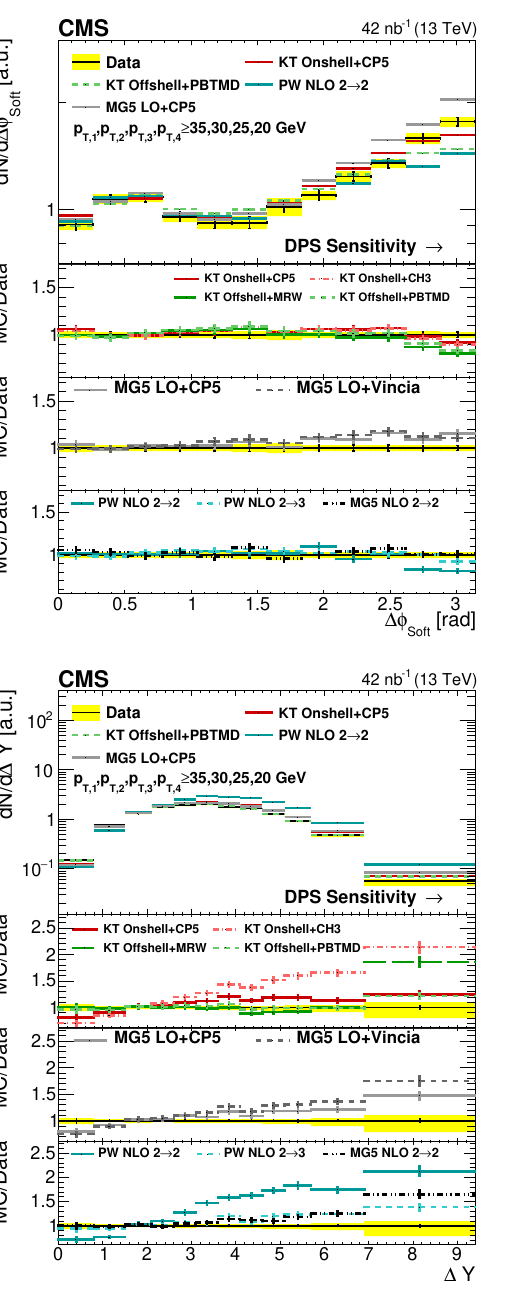
, ∆ φ min , ∆ Y , and φ distributions from data to different Figure 8 . Comparison of the ∆ φ Soft 3j ij KaTie (KT), MadGraph 5_a mc@nlo (MG5), and powheg (PW) implementations in Region I. All distributions have been normalized to regions where a reduced DPS sensitivity is expected. The error bars represent the statistical uncertainty, and the yellow band indicates the total (statisti- cal+systematic) uncertainty on the